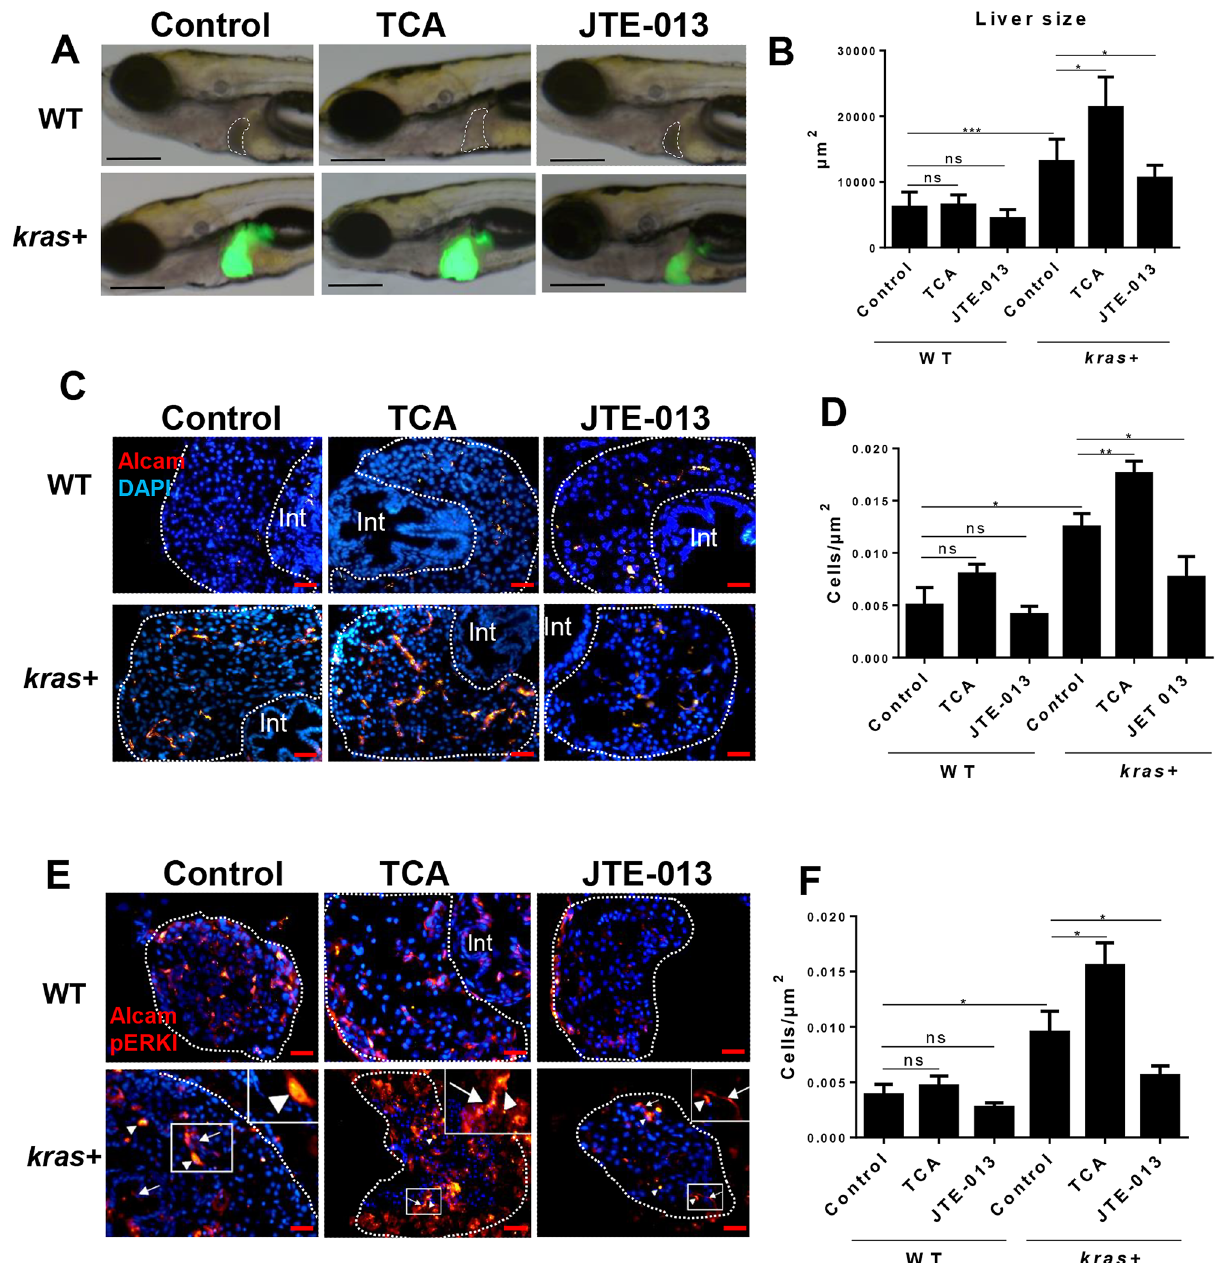
Figure 2. Effect of S1pr2 activation and inhibition on liver size, cholangiocyte density, and downstream marker pERK in kras + and WT zebrafish larvae. 3-dpf kras + and WT zebrafish larvae were treated with either TCA or JTE-013 along with 20 µg/mL Dox till 8 dpf. Samples were collected for immunohistochemistry and all liver sections were counter-stained with DAPI. ( A ) Representative images for liver size after treatment with TCA or JTE-013 in kras + and WT zebrafish. Livers were recognized by GFP fluorescence in kras + larvae and outlined in WT larvae. ( B ) 2D measurements of liver size in different groups. ( C ) Representative images of liver sections stained for Alcam in different groups. ( D ) Quantification of Alcam stained cholangiocytes. ( E ) Co-immunostaining of Alcam and pERK. Alexa Fluor 546 secondary antibody staining was used for Alcam and pERK detection. pERK stained signal is nucleus-localized as exampled in insets and indicated by arrowheads while Alcam staining is more on cell membrane as exampled and indicated by arrows in insets. ( F ). Quantification of pERK stained cholangiocytes. N = 10 each group. Scale bar: 200 μm ( A ) and 20 μm ( C , E ): Statistical significance: *P ˂